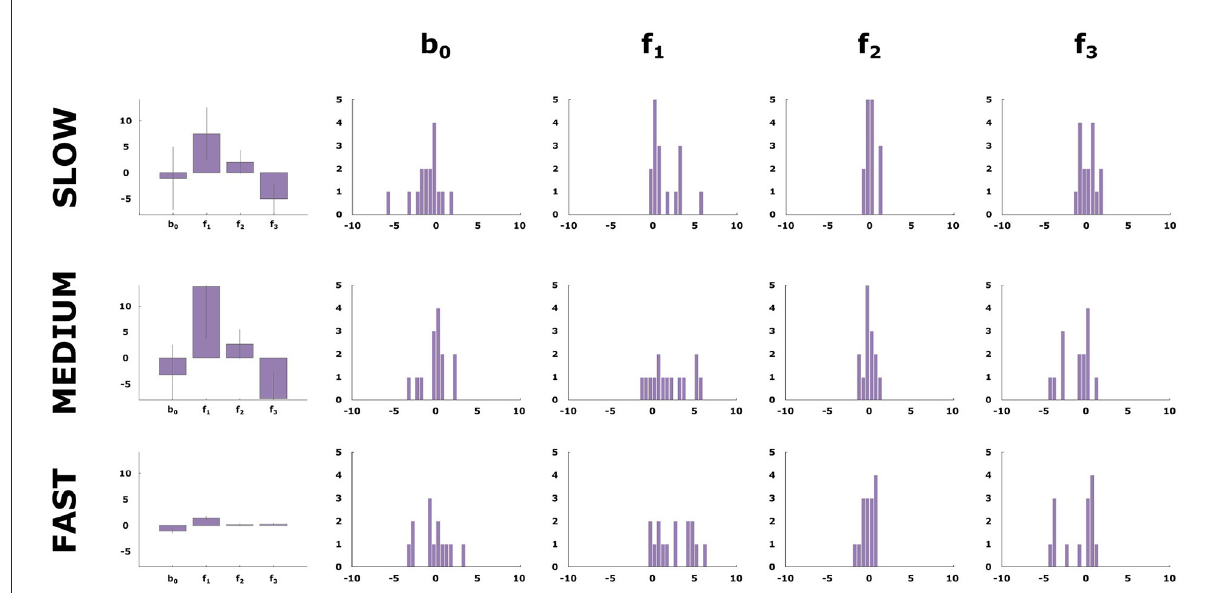
FIGURE6 Logistic regression weights. The first column shows the average weight vector values for the logistic regression performed on subjects’ selected class in each condition. The next three columns show the distribution of the weight vector values for the 16 participants.